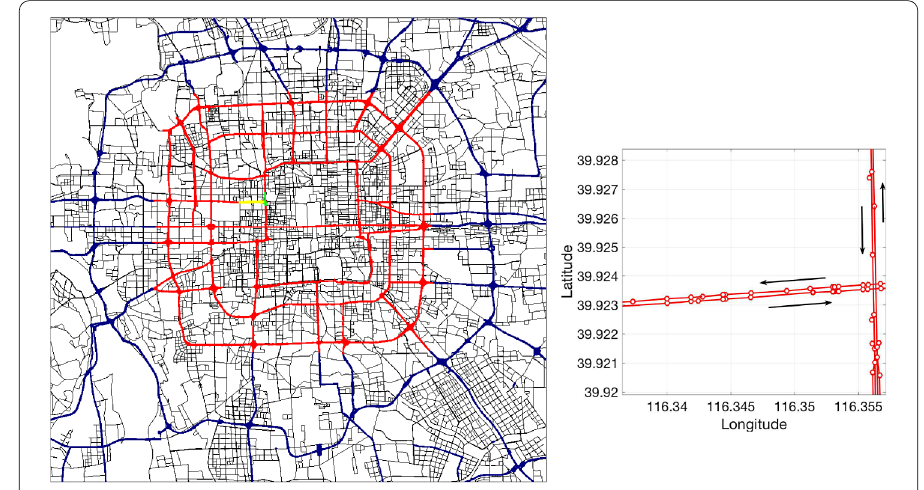
Figure 1 All considered road sections in Beijing. Left: All the 4530 road sections (red segments) in Beijing we analyzed. Right: A local region with two major roads: “Fuchengmen Outer St.” and “W. 2nd Ring Rd.” (yellow and green segments in the left panel). All road sections (nodes) in this local region are shown here (between intersections marked by red circles). The black arrows indicate the traffic direction of the road